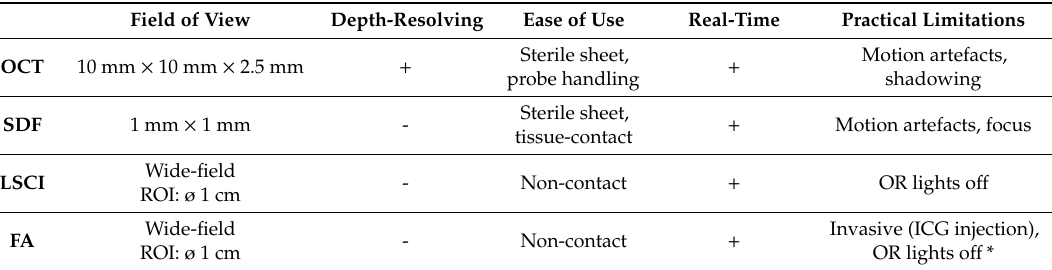
Table 2. Imaging